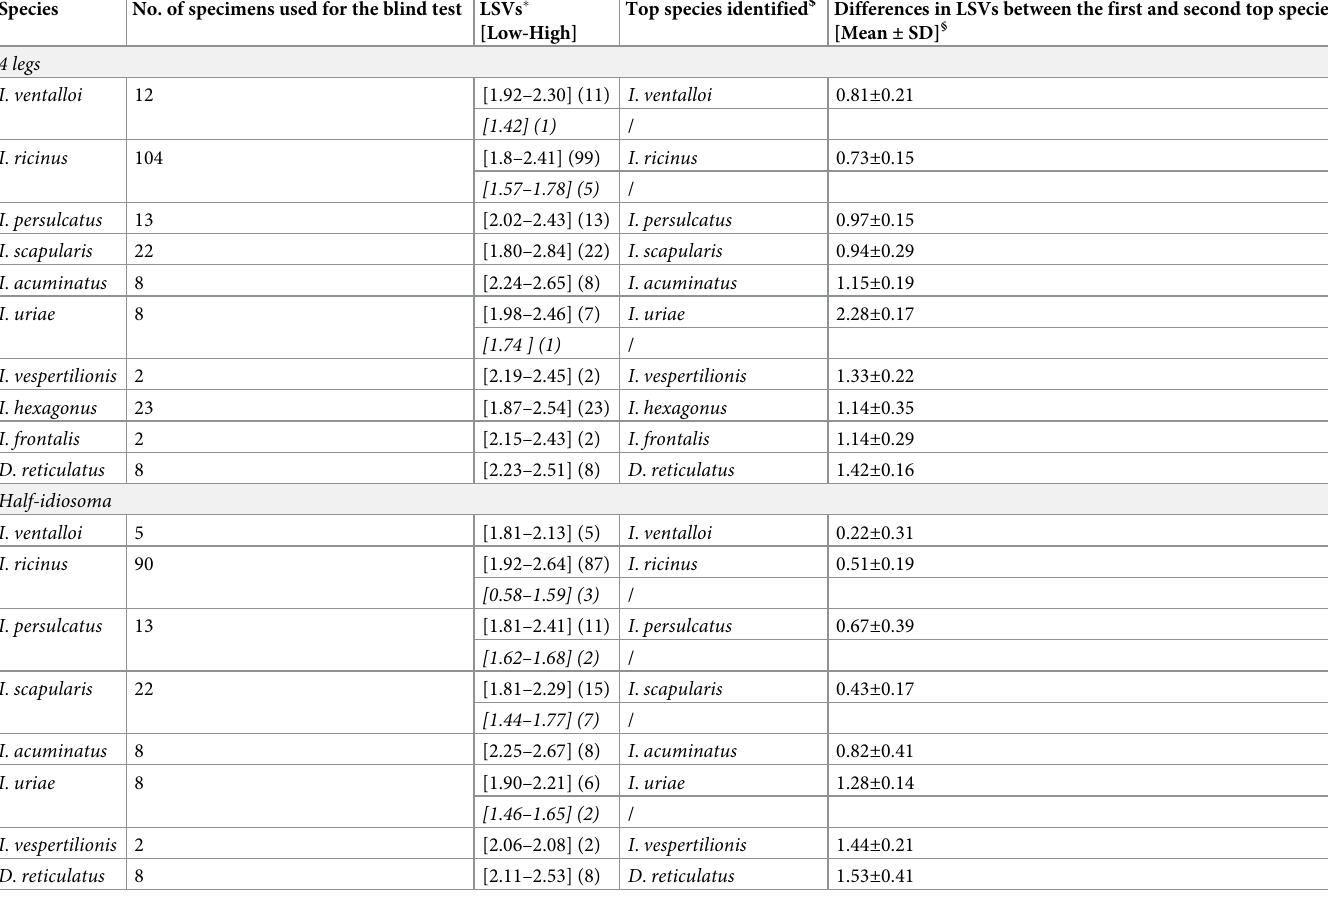
Table 4. Results of the blind test procedure against the four legs and half–idiosoma database. Species No. of specimens used for the blind test LSVs �